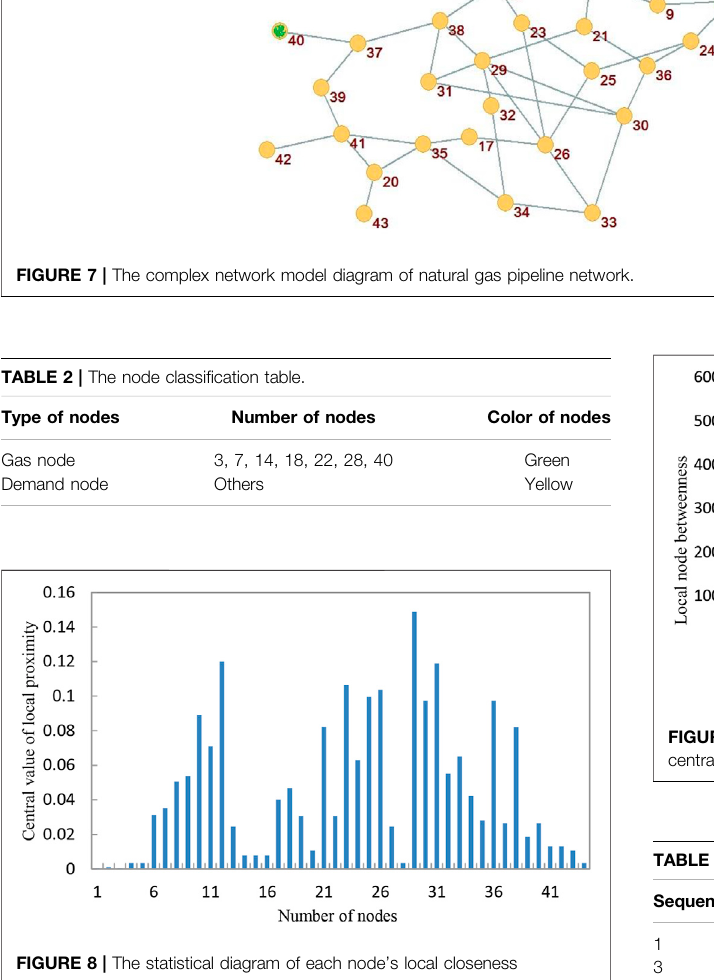
FIGURE 8 | The statistical diagram of each node ’ s local closeness centrality value.